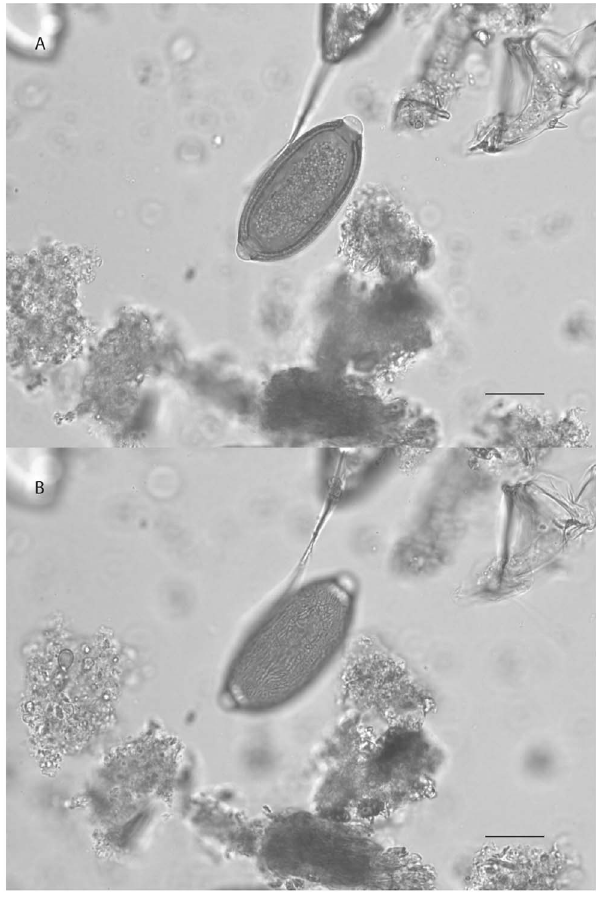
Figure 3. A. Egg of capillariid (65.03 6 28.38 m m) recovered in individual # 1018 in Carspach ‘‘Kilianstollen’’. B. Details on the eggshell ornamentation showing a dense and relatively thin network. Scale bar=20 m m (Photos: M. Le Bailly).